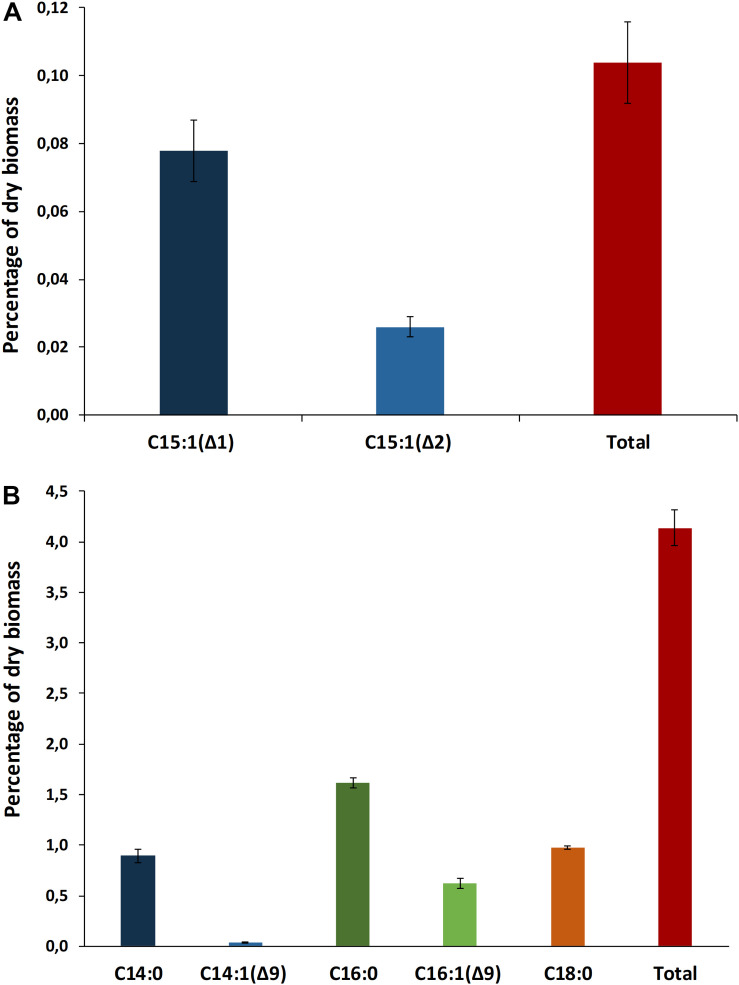
Hydrocarbon profile of Hyella patelloides LEGE 07179. Terminal olefins with chain length of C15 were identified (A), and fatty acid composition of Hyella patelloides with chain lengths of C14, C16, and C18 were identified (B). Number after the colon indicates the number of double bonds, while the number after the triangle indicates the position of the double bound. Data are the means of three biological replicates, and error bars represent standard deviations.